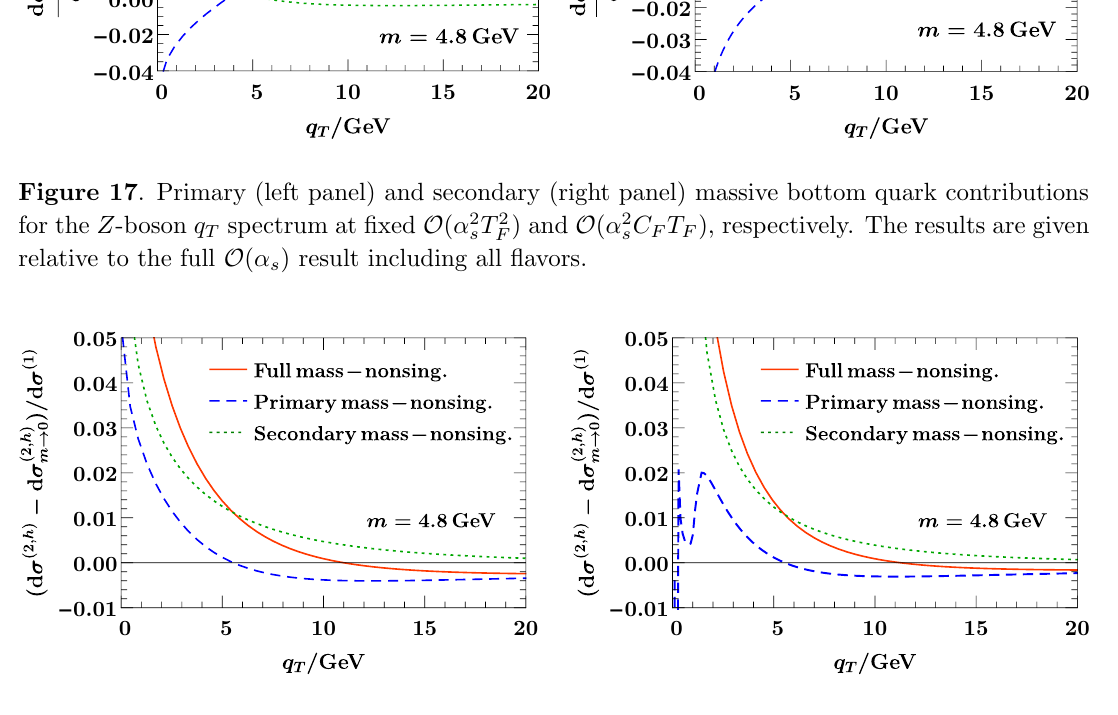
Figure 18 . Di(cid:11)erent types of mass nonsingular corrections for Z -boson production at (cid:22) = m b (left panel) and (cid:22) = q T (right